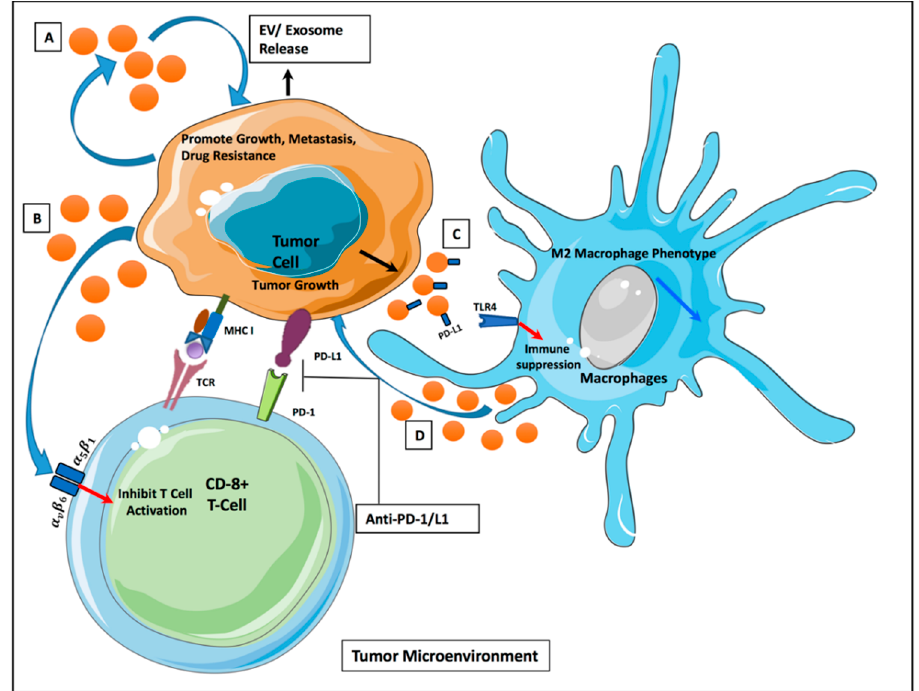
Figure 1. Intercellular communication via extracellular vesicles (EVs) in tumor microenvironment. ( A ) Tumor-derived EVs (TDEs) release promotes tumor growth / metastasis / progression. ( B ) TDEs release inhibits T-cell activation via alpha / beta integrin receptors. ( C ) PD-L1 expressed on TDEs leads to macrophage suppression through TLR4 signaling. ( D ) Release of EVs from macrophage promotes tumor growth via miRNA signaling.